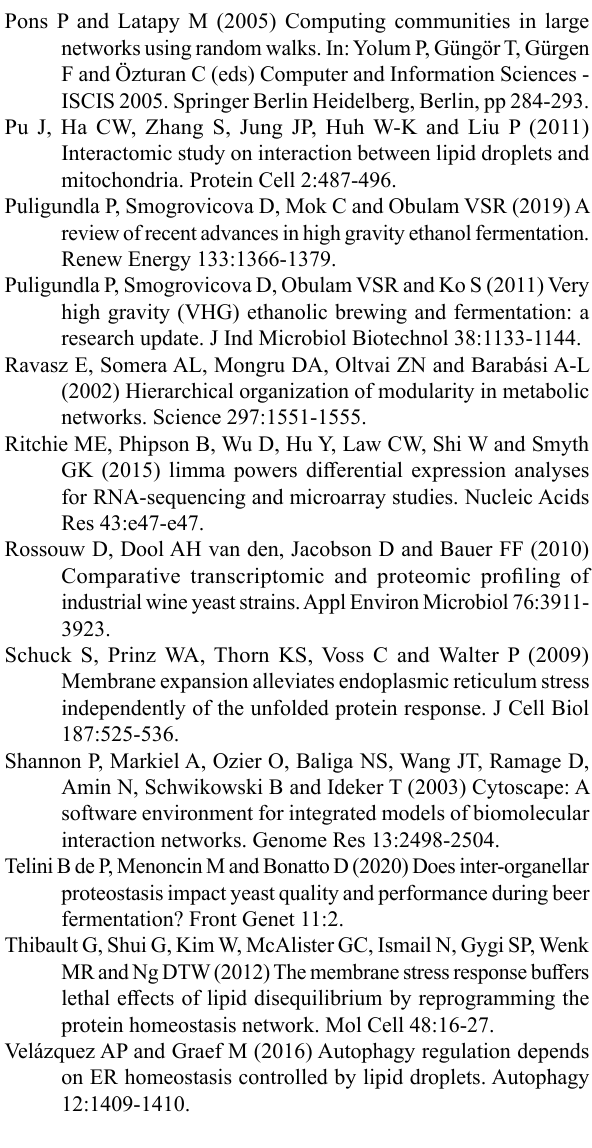
Table S1 – DNA microarray gene expression datasets used in this work. Table S2 – Upregulated ALP Pan-DEGs associated with lipid droplets. Table S3 – Transcriptome and proteolipidome data of nodes associated with lipid droplet-linked protein (LDP)